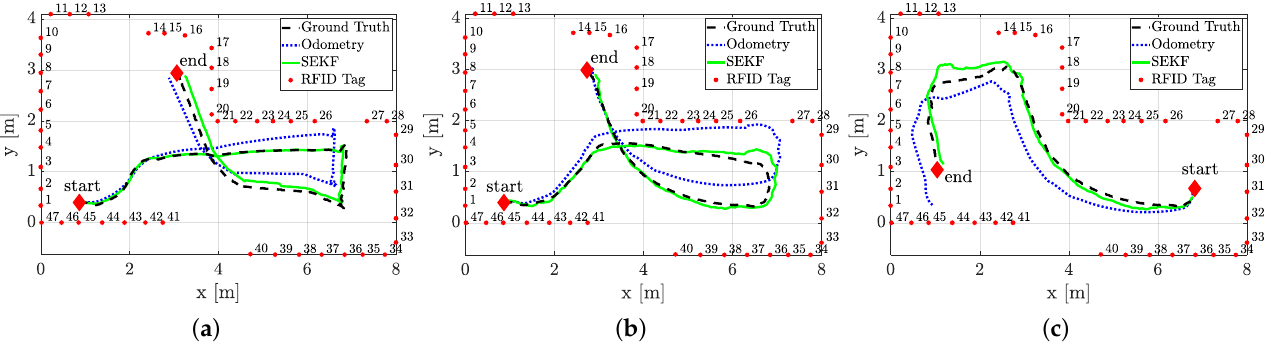
Figure 11. Three ( a – c ) sample trajectories of the robot (dashed line), SEKF estimates (solid line) and dead reckoning only reconstructed trajectories (dotted line). In all the pictures, the starting and ending positions of the trajectories as well as the RFID tag locations are reported as